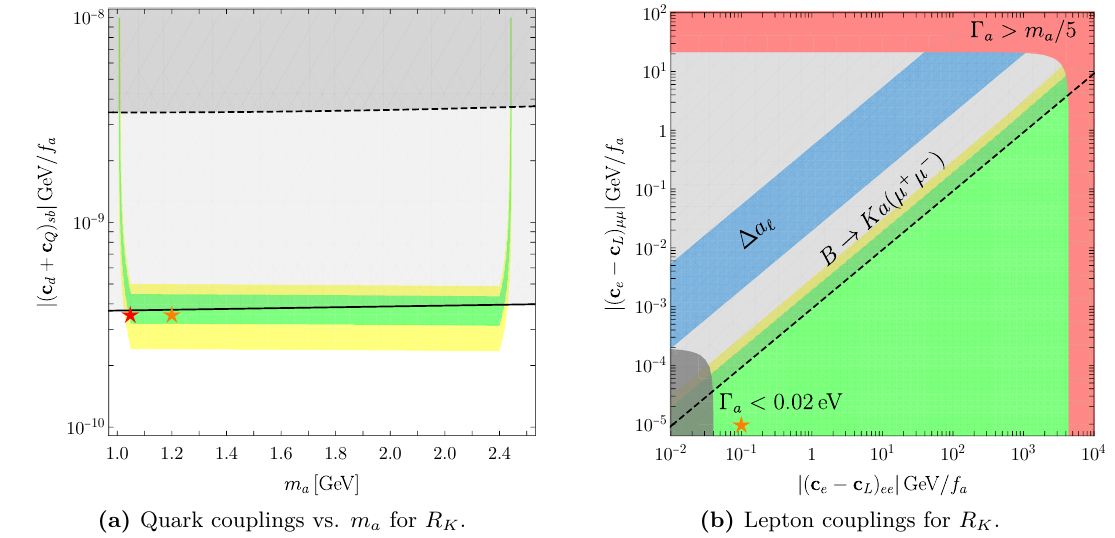
(a) Quark couplings vs. m a for R K . Figure 7. ALP mass on-shell within the central bin range. In green (yellow) the 1 σ (2 σ ) solutions to R . The stars correspond to the benchmark ALP-lepton couplings K ( | ( c ) ( c ) ) = (10 − 1 , 10 − 5 ) GeV − 1 , for two different values of the ALP e − c L ee | /f a , | e − c L µµ | /f a mass as discussed in the text. On the left: parameter space for ALP-quark couplings vs. m grey the experimental bounds from B → Kµ + µ − (enclosed by the dashed line) and B → Ke + e − (enclosed by the solid line). On the right: parameter space | ( c m a = 1 . 2 GeV and | ( c d + c Q ) sb | /f a = 3 . 8 × 10 − 10 . The shaded red region corresponds to the